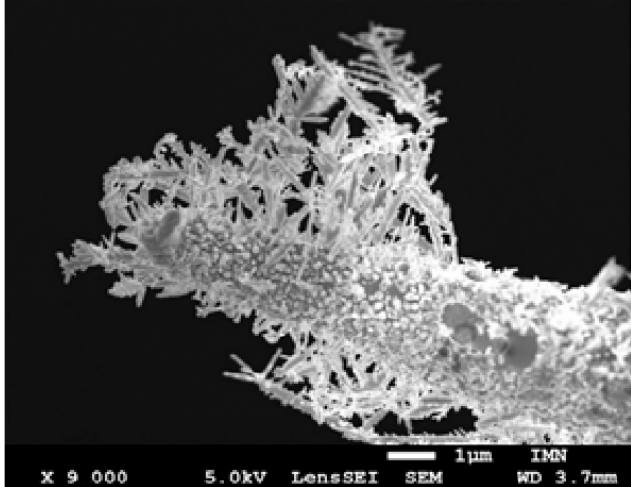
Figure 4. Needle electrode covered with a dendrite coat after experiment in atmospheric air. The needle electrode and the anvil electrodes were spaced within a few micrometers from one another at the start of the experiment.